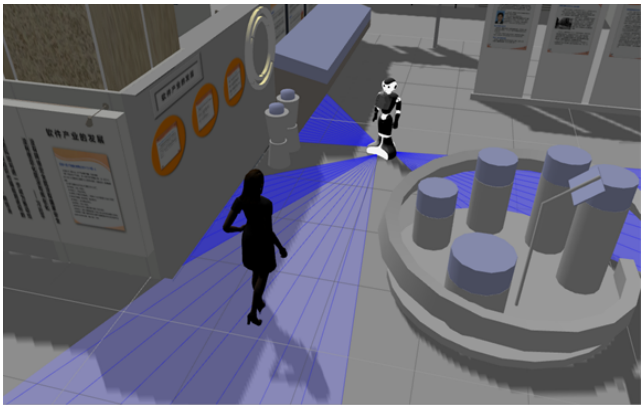
Figure 16. Environment with a human.